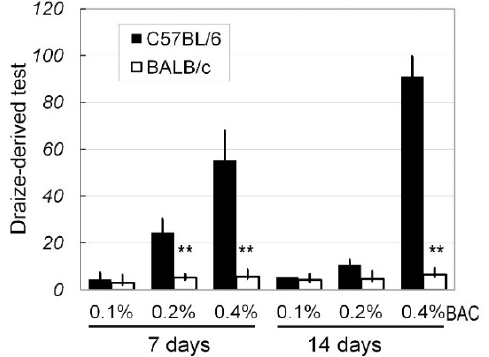
Figure 1. A comparison of ocular surface disruptions by the scores of the Draize-derived test in C57BL/6 and BALB/c mice. Benzalkonium chloride (BAC) eye drops at various concentrations were topically applied twice daily, and the effects were evaluated on Day 7 and Day 14. The criteria for the scores of the Draize-derived test are described in the main text (Materials and Methods). Based on 10 eyes on Day 7 and 10 eyes on Day 14, the results are presented as the mean ± SD. ** p < 0.01; **: C57BL/6 vs. BALB/c.